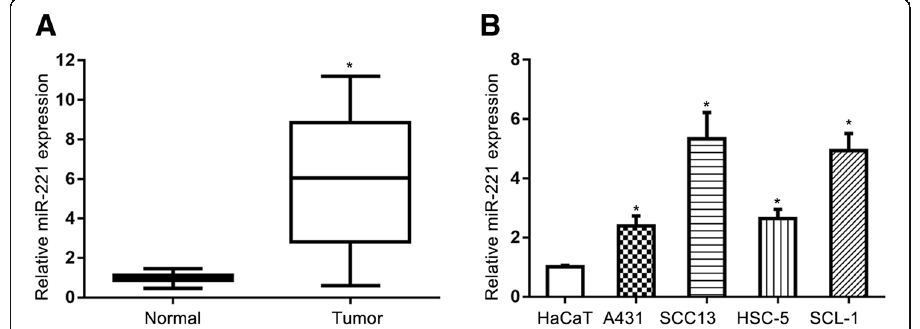
Fig. 1 Expression of miR-221 in CSCC tissues and cell lines. a qPCR analysis of miR-221 in tumor and adjacent non-tumor tissues. b Average relative miR-221 level in CSCC cell lines (A431, SCC13, HSC-5 and SCL-1) and the human normal skin cell line HaCaT. Data are means ± SD of three independent experiments. * P < 0.05, compared with